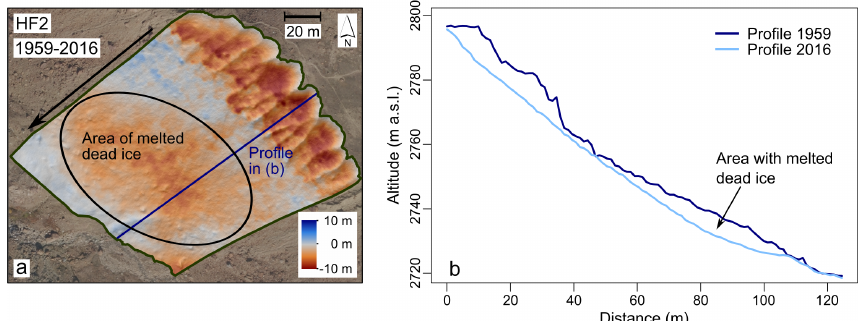
Figure 5. Reaction of lateral moraine slopes to dead-ice melting for the example of moraine section HF2: (a) 1959–2016 DoD and (b) length profile through the DEMs of 1959 and 2016 (aerial images of 1959 are from IGMI, while the 2016 images are from the Hydrographic Office of the Agency for Civil Protection of the Autonomous Province of Bolzano-South Tyrol).